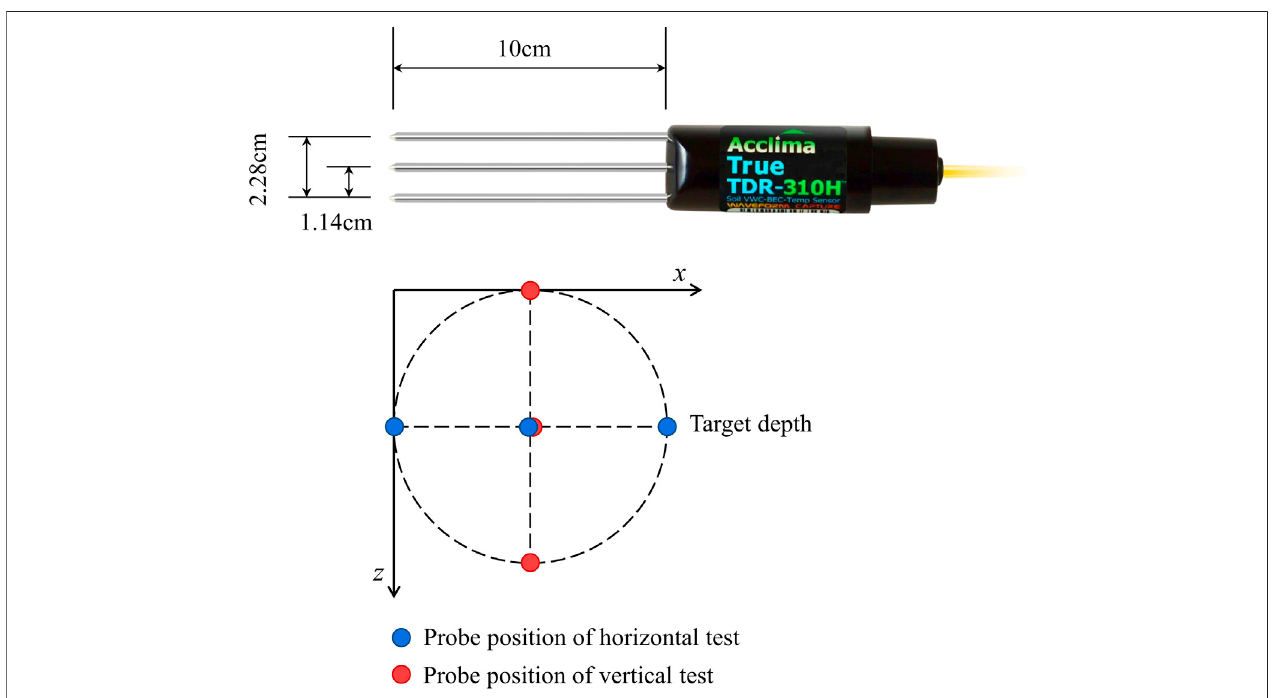
FIGURE 4 | TDR-310H instrument speci fi cation diagram and probe direction.